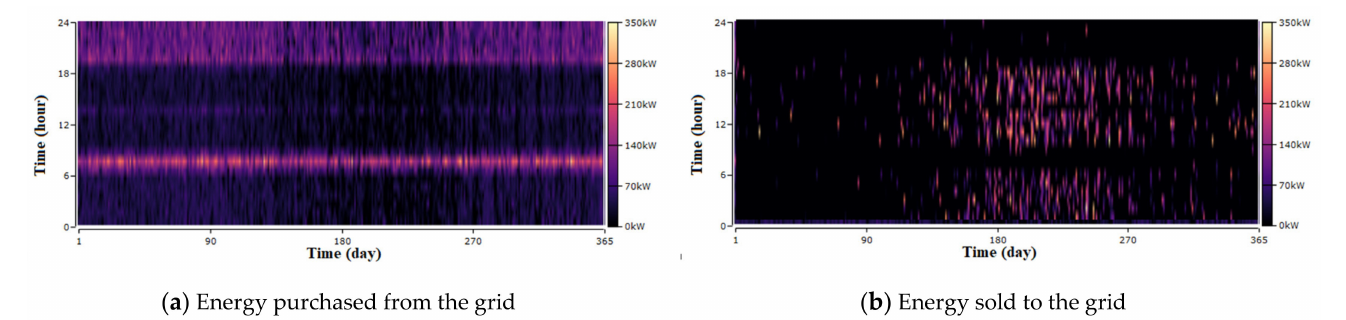
Figure 15. Putrajaya, RX-20KH3 wind turbine case.